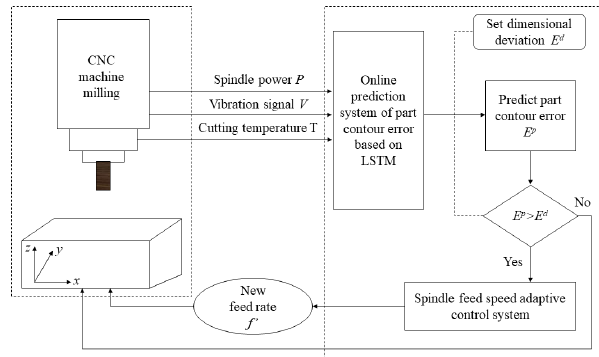
Figure 1. Feed speed adaptive control system based on LSTM.